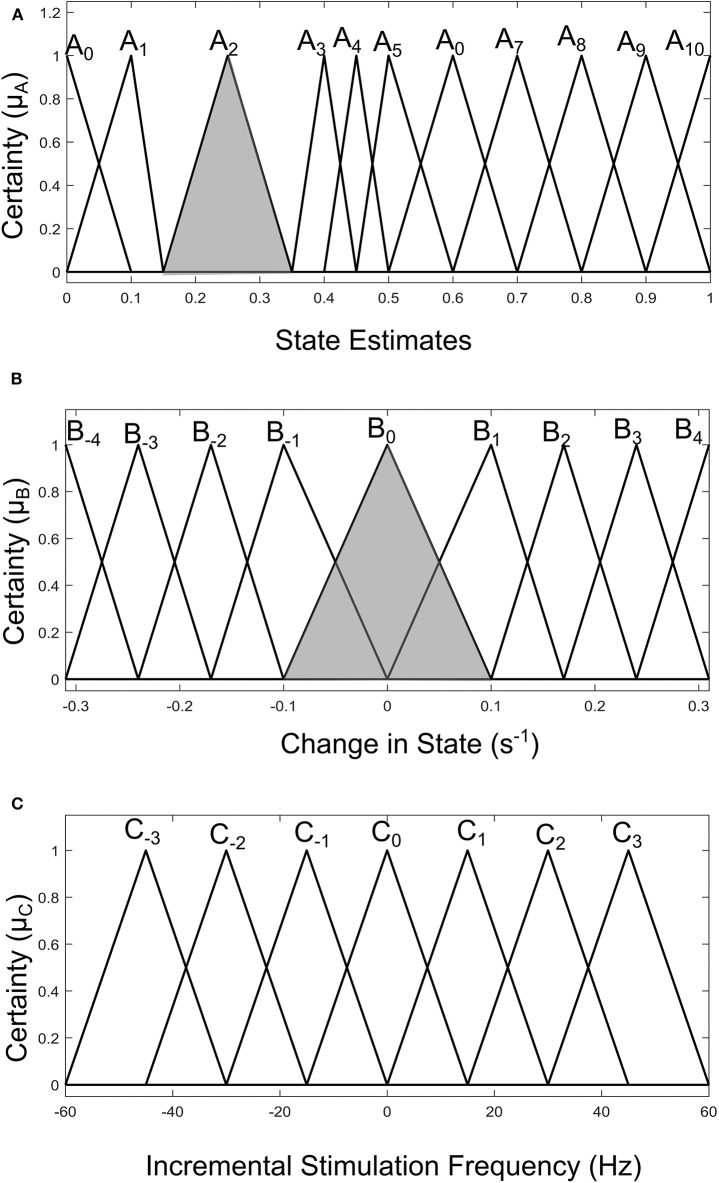
Input-output membership functions for the fuzzy controller driven by SVM state estimates. (A) Membership functions for the state estimates. (B) Membership functions for the rate of change in state. (C) Membership function for the incremental stimulation frequency.